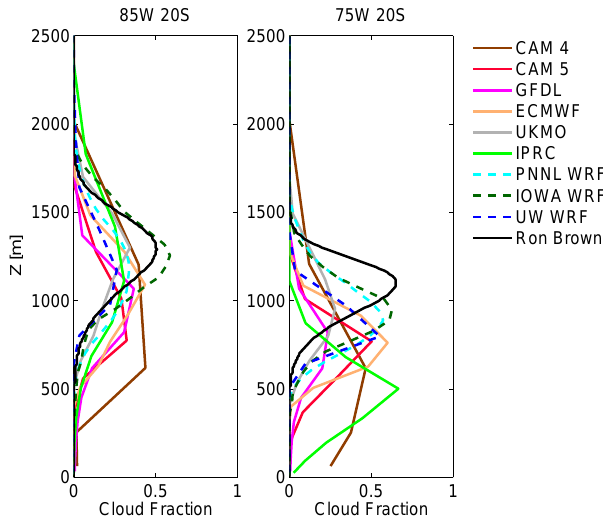
Figure 5. Mean model cloud fraction at 85 ◦ W, 20 ◦ S (left panel) and at 75 ◦ W, 20 ◦ S (right panel). Also plotted is cloud fraction in- ferred from R/V Ron Brown ship-based measurements over nearby longitudes from Burleyson et al. (2013). See text for more